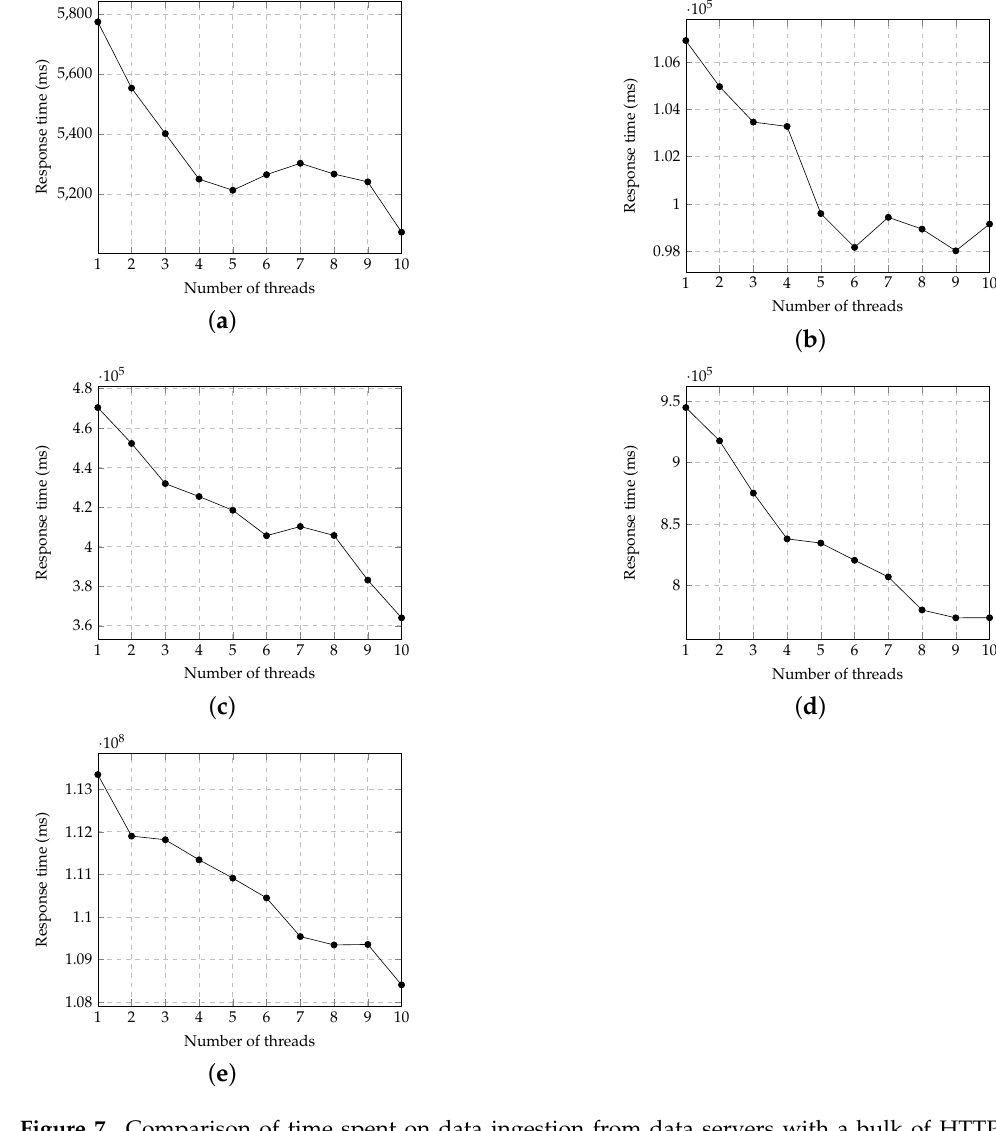
Figure 7. Comparison of time spent on data ingestion from data servers with a bulk of HTTP GET requests with a different number of threads in a multi-thread pool. ( a ) WF10 containing 61,881 historical records. A total of 62 requests were sent to server. ( b ) PM2.5RD containing 798,772 historical records. A total of 80 requests were sent to server. ( c ) TCOD containing 1,387,324 historical records. A total of 139 requests were sent to server. ( d ) ORMS containing 2,738,519 historical records. A total of 274 requests were sent to server. ( e ) RMDAS containing 29,069,409 historical records. A total of 2907 requests were sent to